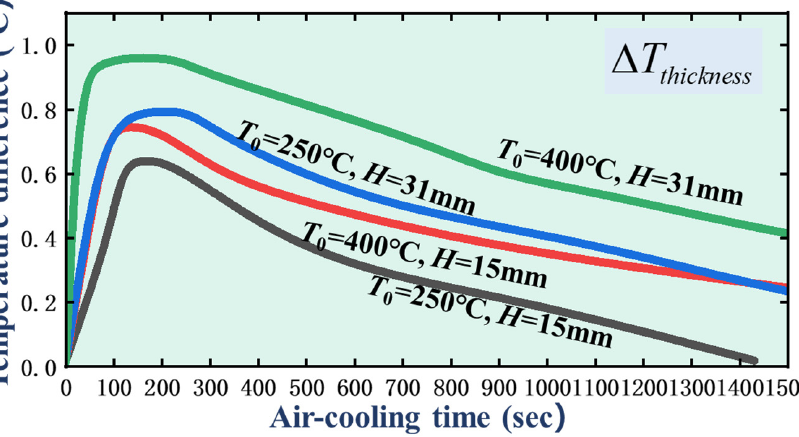
Figure 3. Variation in ∆ T thickness over time under different plate thicknesses and initial